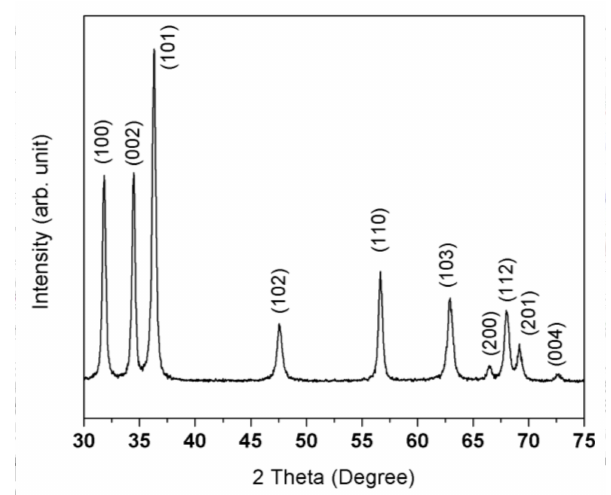
Figure 2. X-ray diffraction pattern of the as-prepared ZnO nanofibers.